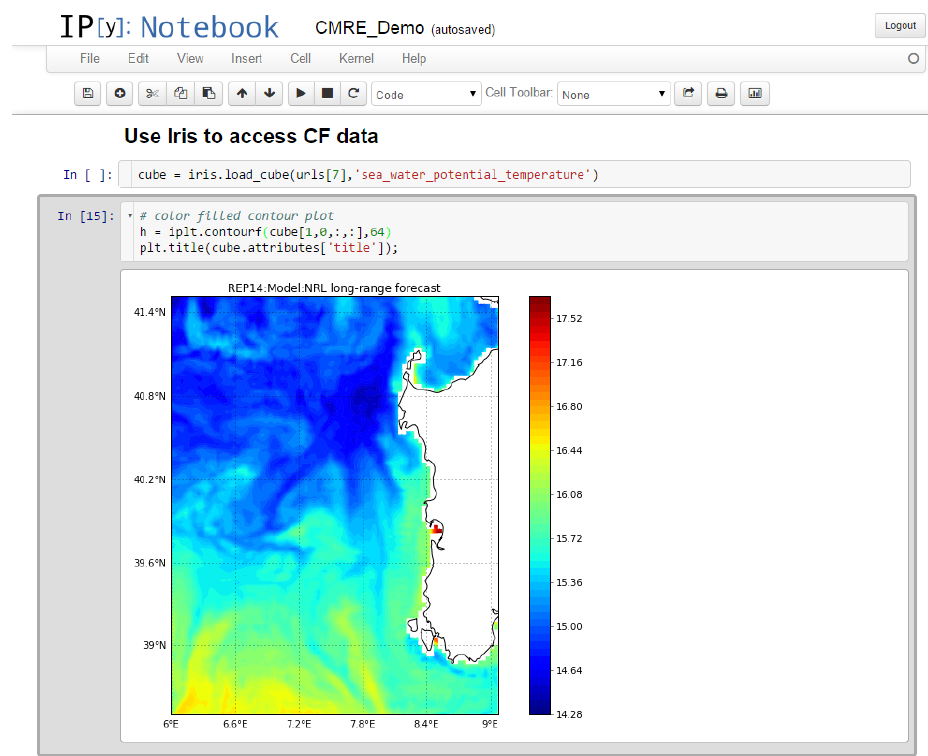
Figure 6. Another snippet from the IPython Notebook demo, extracting data from one of the discovered OPeNDAP URLs using the Iris package. © North Atlantic Treaty Organization, all rights reserved. Provided by STO-CMRE.